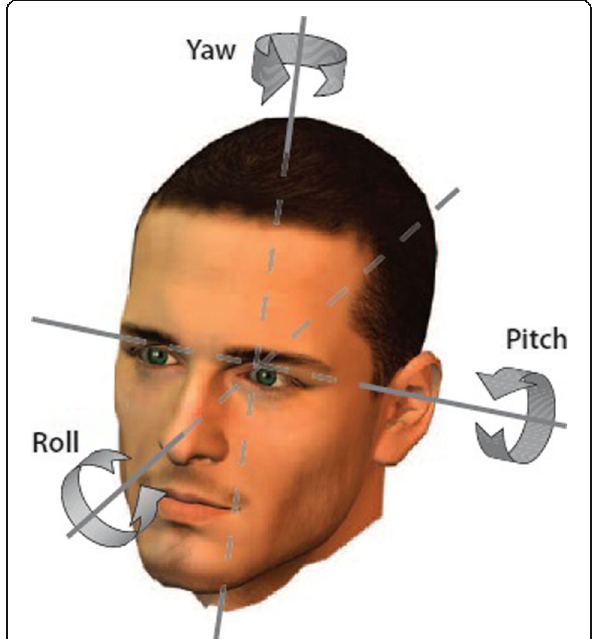
Fig. 1 Three degrees of freedom for face pose